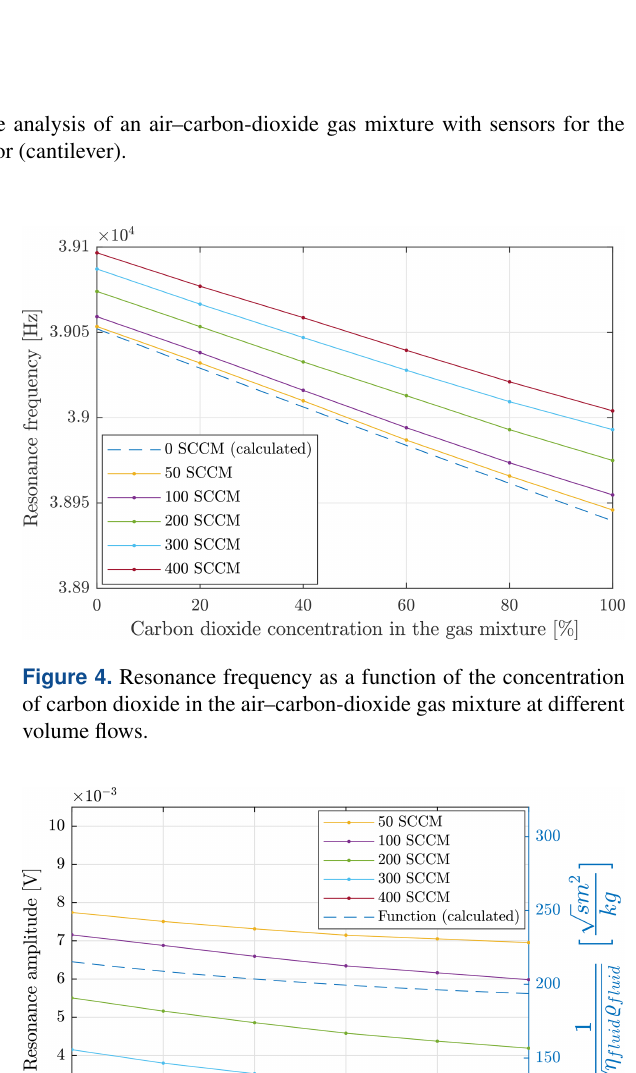
caused by the factor 1 √ in the investigated flow range. η fluid (cid:37) fluid All curves for different flows show this dependency. The